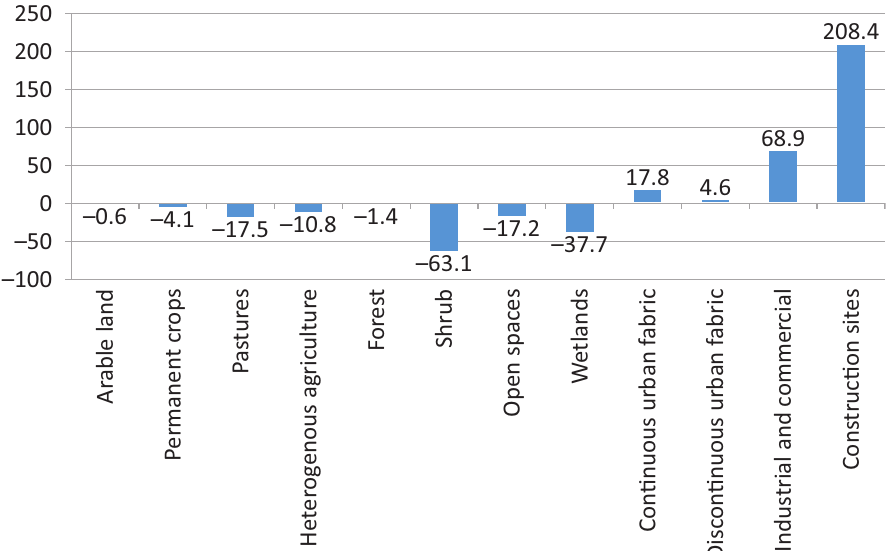
Figure 7. Percentage change of land-use classes in Transport Scenario (2000–2025). gion. Therefore, mixed-use development could be more intense both in the inner city and along the transport cor- ridors considering that mixed-use developments are sup- ported by both planning policy and required transporta- tion networks. This implies that the inner city of Leipzig will attract more population from the suburban areas and countryside thanks to the increasing investments in brownfield sites adjacent to the inner